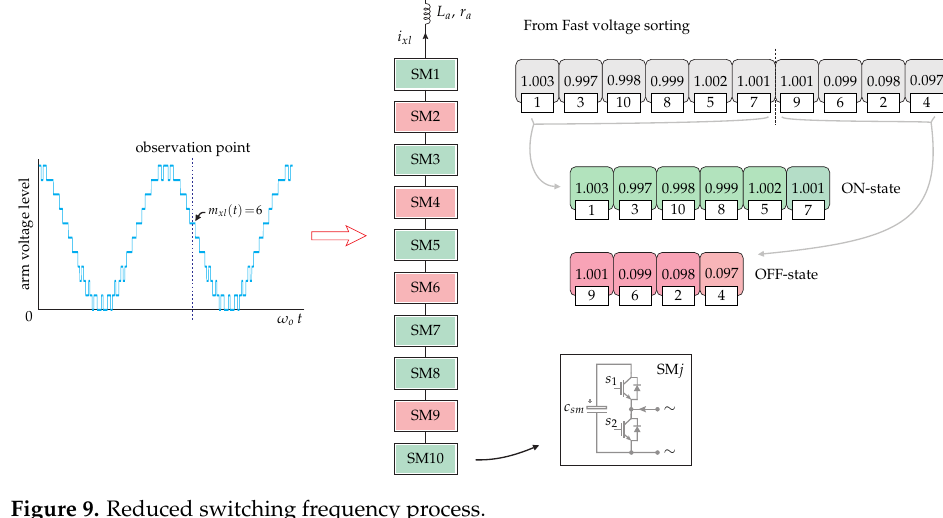
Figure 9. Reduced switching frequency process.